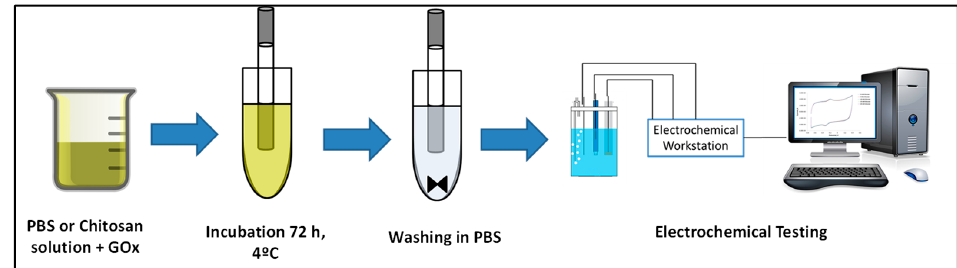
Figure 1. GOx immobilization procedure and working operation.